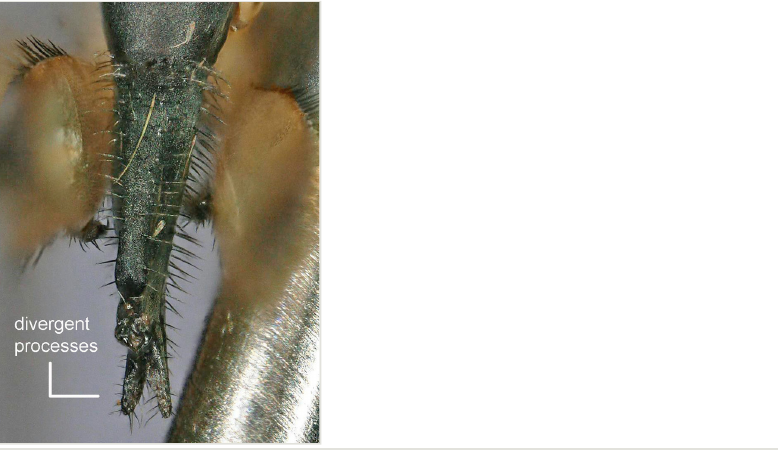
Figure 4. Oviscape, dorsal, of Melaloncha ( Melaloncha ) peacockorum new